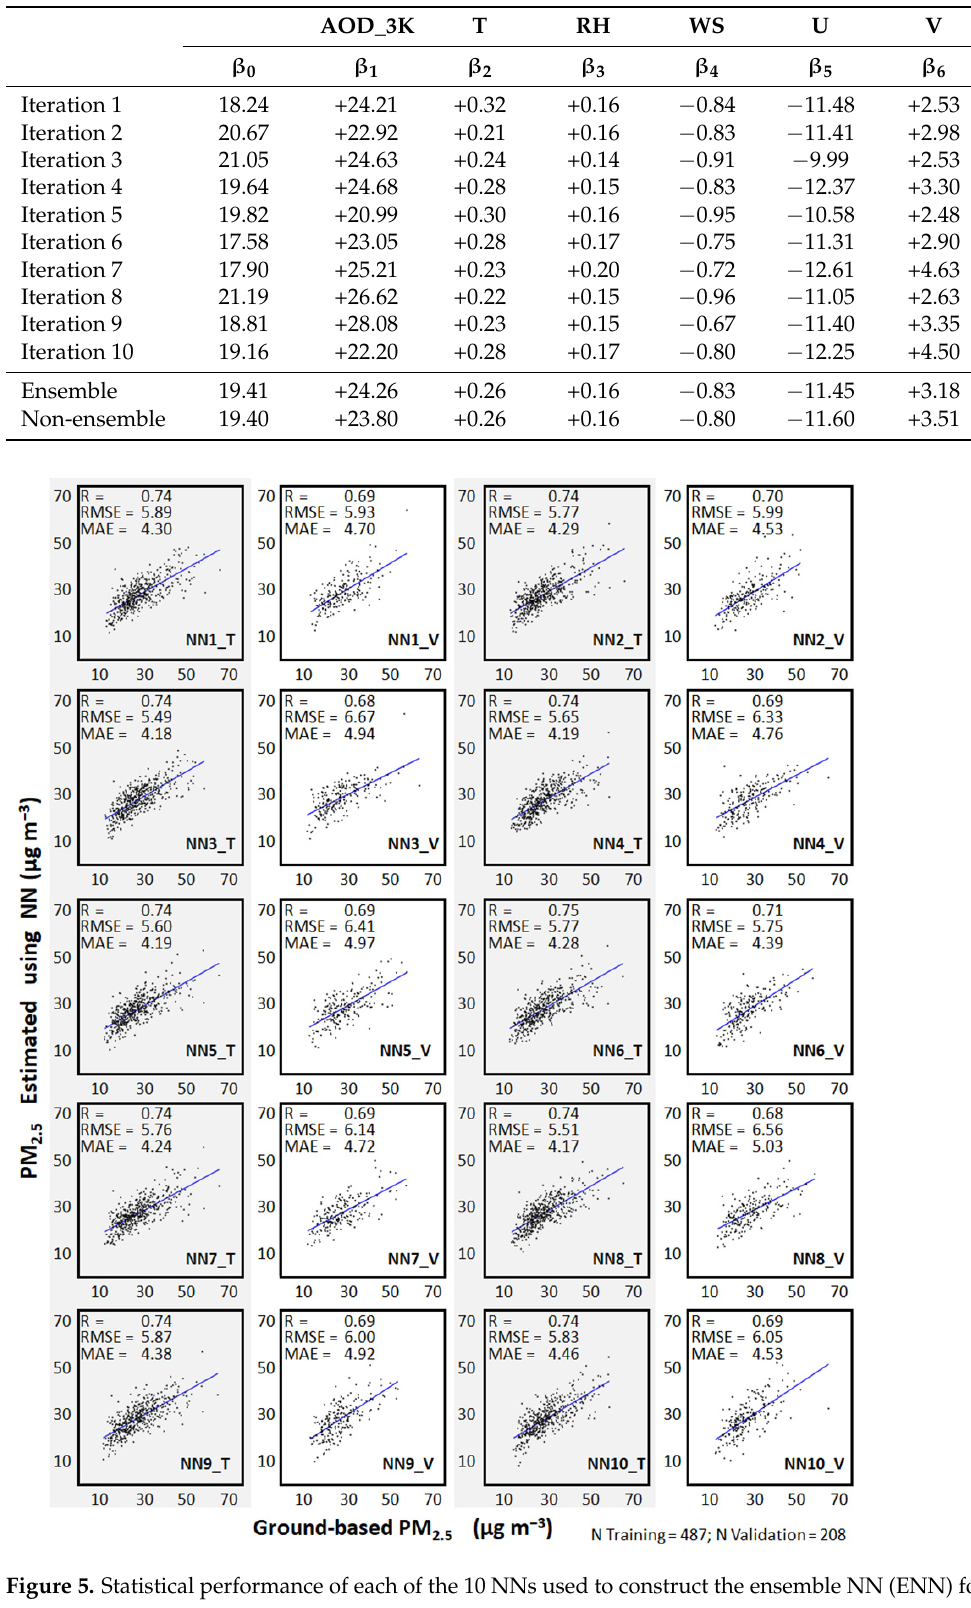
Table 4. Ensemble model development and comparison with MLR using the original best dataset.